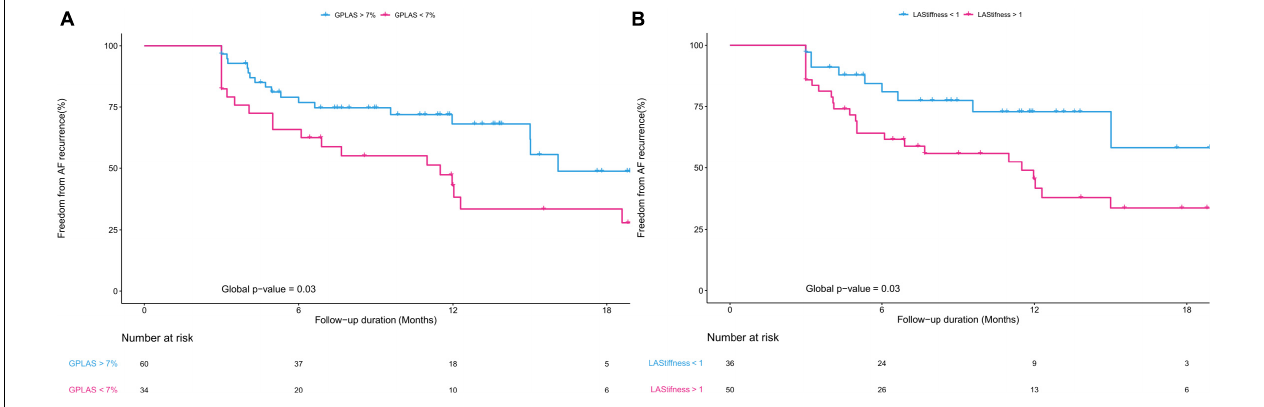
Frontiers in Cardiovascular Medicine |